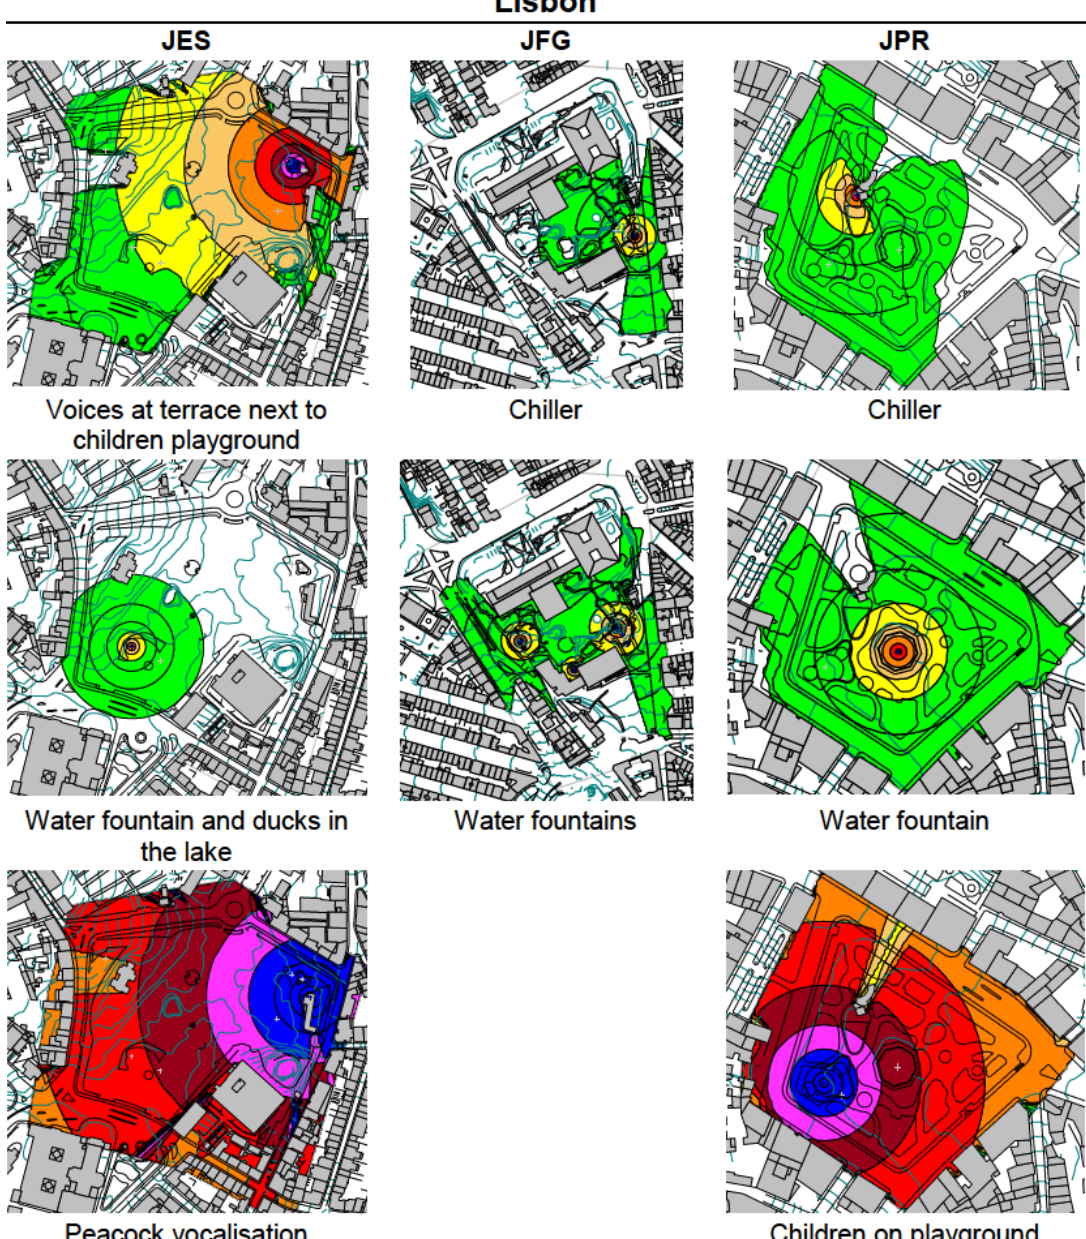
Figure 7: Audibility maps of main sound sources in Lisbon parks.